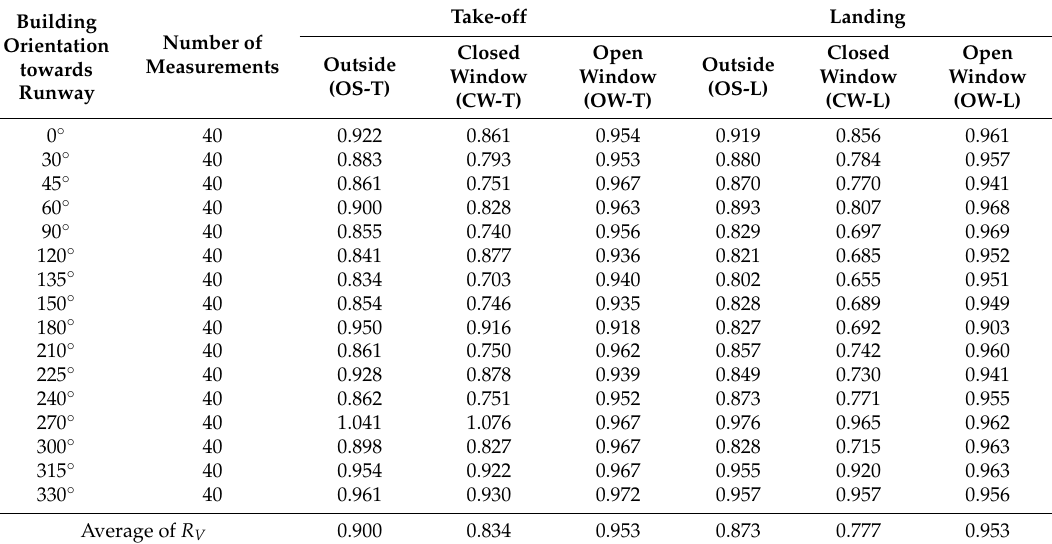
Table 3. The Average Relative value ( R V ).